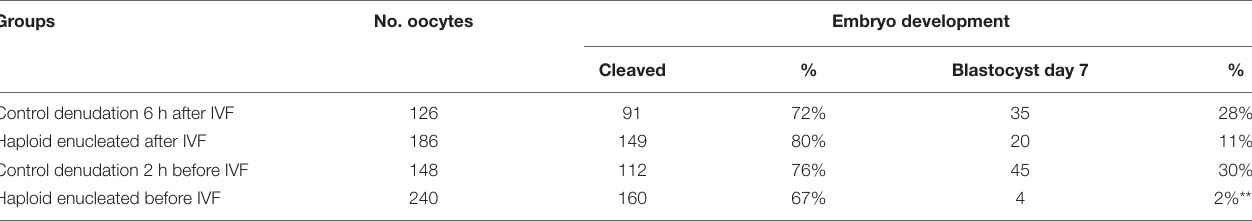
TABLE 1 | Development to cleavage and blastocyst stages at Day-2 (48 h) and Day-7 (168 h) post insemination (hpi) of control and putative androgenetic embryos manipulated both before (pre-IVF) and after (post-IVF) in vitro fertilization (IVF). Groups